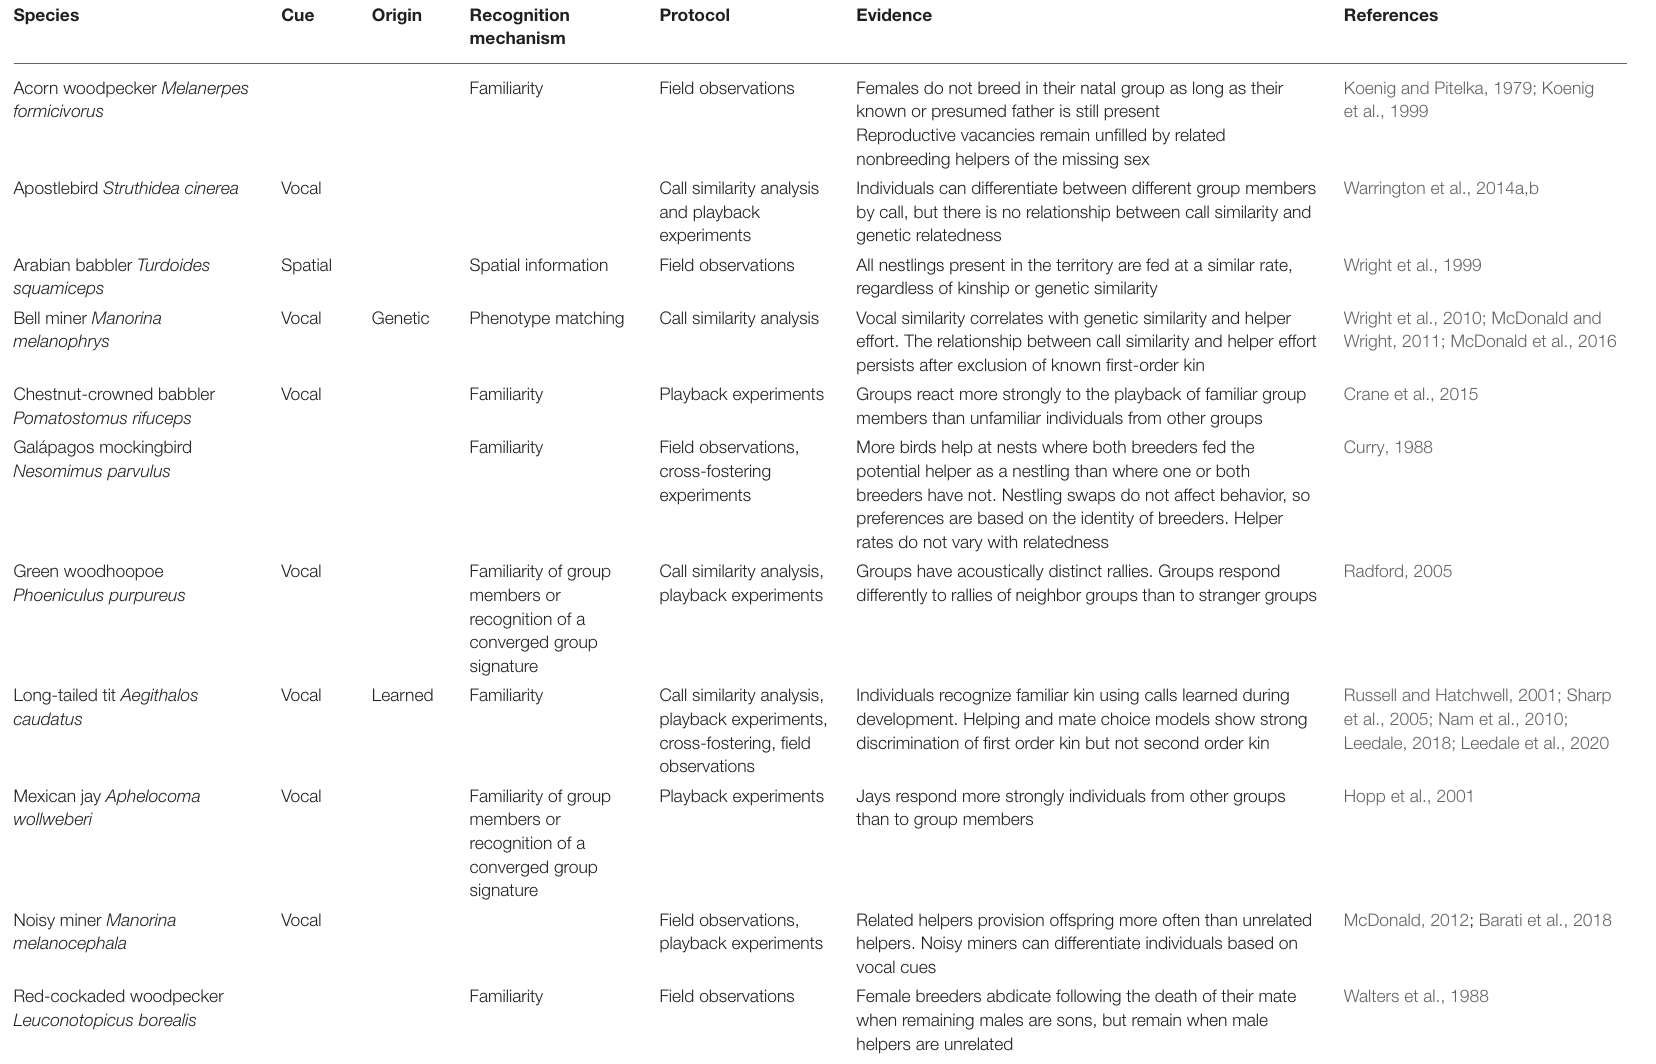
TABLE 3 | Summary of empirical field studies of cooperatively breeding birds in which kin or group discrimination has been identified.